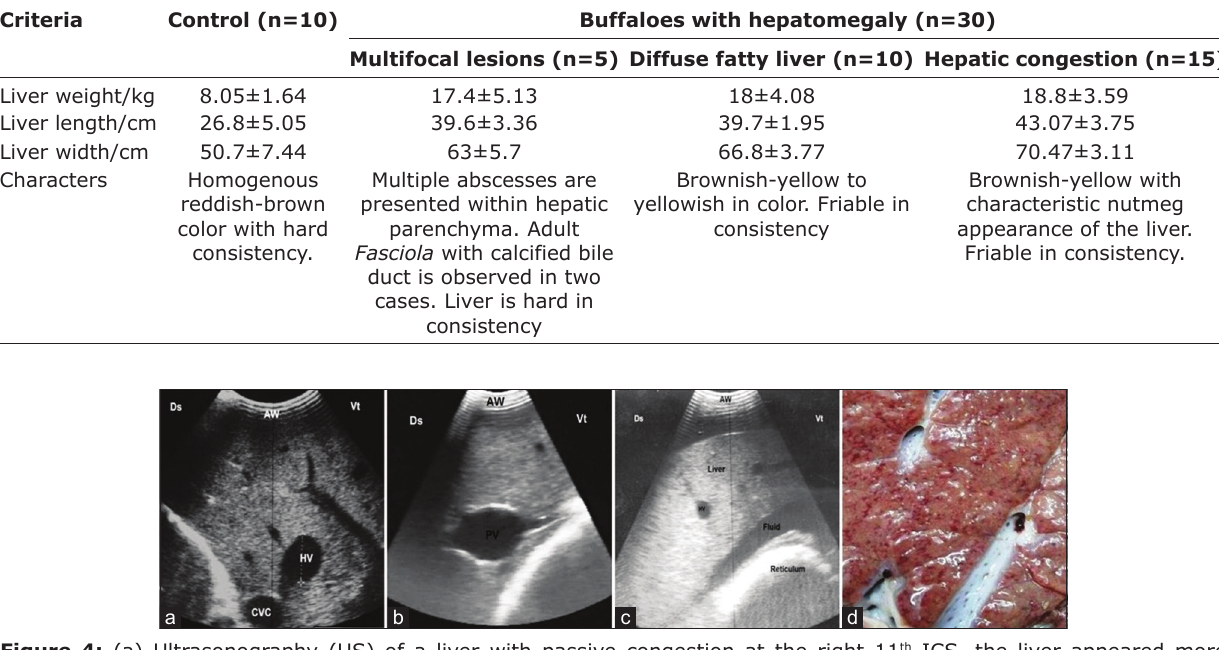
Figure-4: (a) Ultrasonography (US) of a liver with passive congestion at the right 11 th ICS, the liver appeared more echogenic with round-shaped caudal vena cava. (b) US of a liver at the 10 th ICS appears with dilated portal veins due to passive congestion. (c) US of a liver with passive congestion at the 7 th ICS, the liver appeared floated in anechoic ascitic fluid. (d) Necropsy of a piece of liver with chronic hepatic congestion with nutmeg appearance, note the dark red congested regions (accumulation of red blood cells) in hepatic tissues. AW=Abdominal wall, Ds=Dorsal,